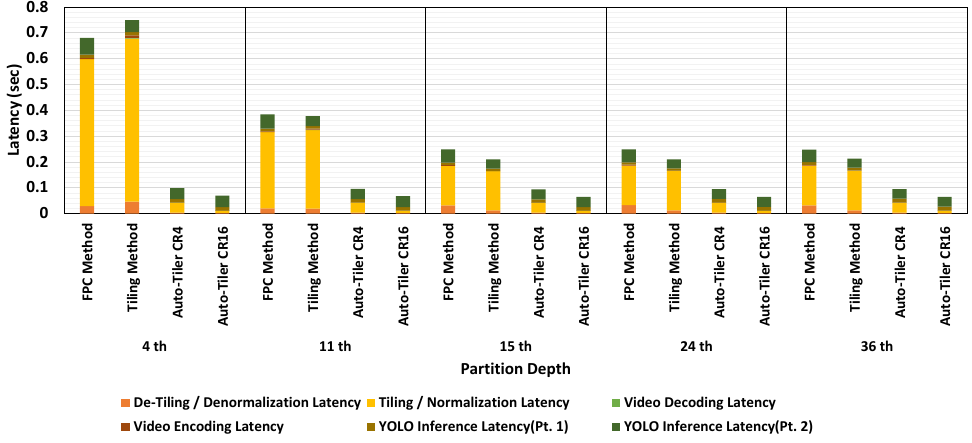
Figure 14. Latency comparison of Tiling, Frame per Channel, and auto-tiling method. For the Tiling and FPC method, the total latency is dominated by tiling and normaliza- tion latency. However, when utilizing an auto-tiler, we can see a considerable improvement in that latency. The reason for this improvement is that the latency for tiling or normal- ization depends on the size of a frame. The frame size of the Tiling method ranges from 832 × 832 × 1 to 1664 × 1664 × 1 and that of the FPC method ranges from 52 × 52 × 256 to 208 × 208 × 64. Auto-tiler on the other hand reduces the dimension to 208 × 208 × 1 or 416 × 416 × 1 depending on the inference depth. This reduced frame size alongside with the removal of tiling process altogether significantly reduces the latency required to tile, normalize, and recover the feature space. Consequently, we can observe an average of 73.2% and 81.3% reduction for CR4 and CR16 mode respectively in terms of overall latency compared to the existing